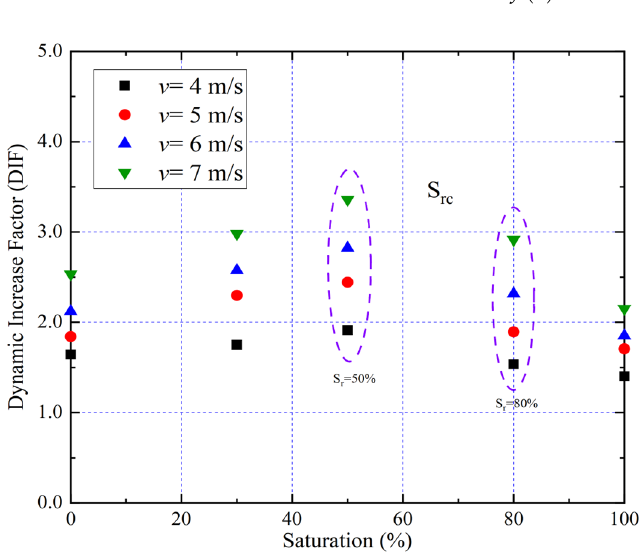
Figure 11. DIF versus impact velocity and saturation of the sample.